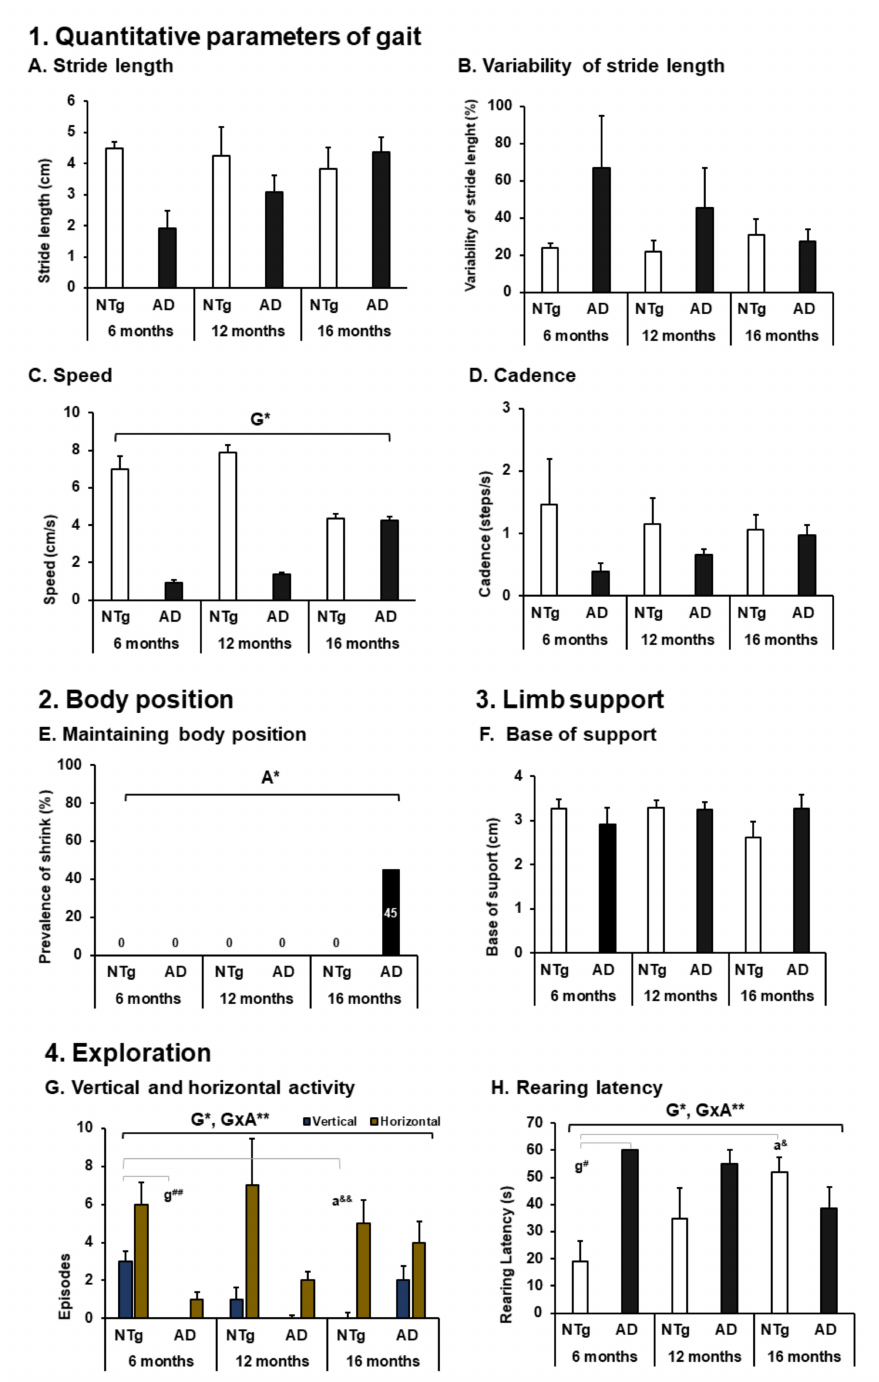
Figure 2. ACTIVITY: Spontaneous gait and exploration. 1. Quantitative parameters of gait; ( A ) stride length; ( B ) variability of stride length; ( C ) speed; ( D ) cadence. 3. Limb support. ( F ) Base of support. 4. Exploration. ( G ) Vertical and horizontal activity; ( H ) rearing latency. The results are expressed as mean ± SEM. Statistics: one-way ANOVA, Age effect expressed as ( A ); Genotype effect expressed as ( G ); Genotype and Age interaction effect is expressed as (GxA); * p < 0.05, ** p < 0.01 followed by post hoc Bonferroni test, * p < 0.05, ** p < 0.01,; differences between NTg vs. 3xTg-AD are expressed (g): # p < 0.05 , ## p < 0.01; differences between age in each group are expressed (a): & p < 0.05, && p < 0.01. 2. Body position; ( E ) maintaining body position, the results are expressed as prevalence (%). Statistics: Fisher’s exact test, Age effect are expressed as ( A ), Genotype effect are expressed as ( G ); Genotype and Age interaction effect are expressed as (GxA); * p < 0.05 and ** p <